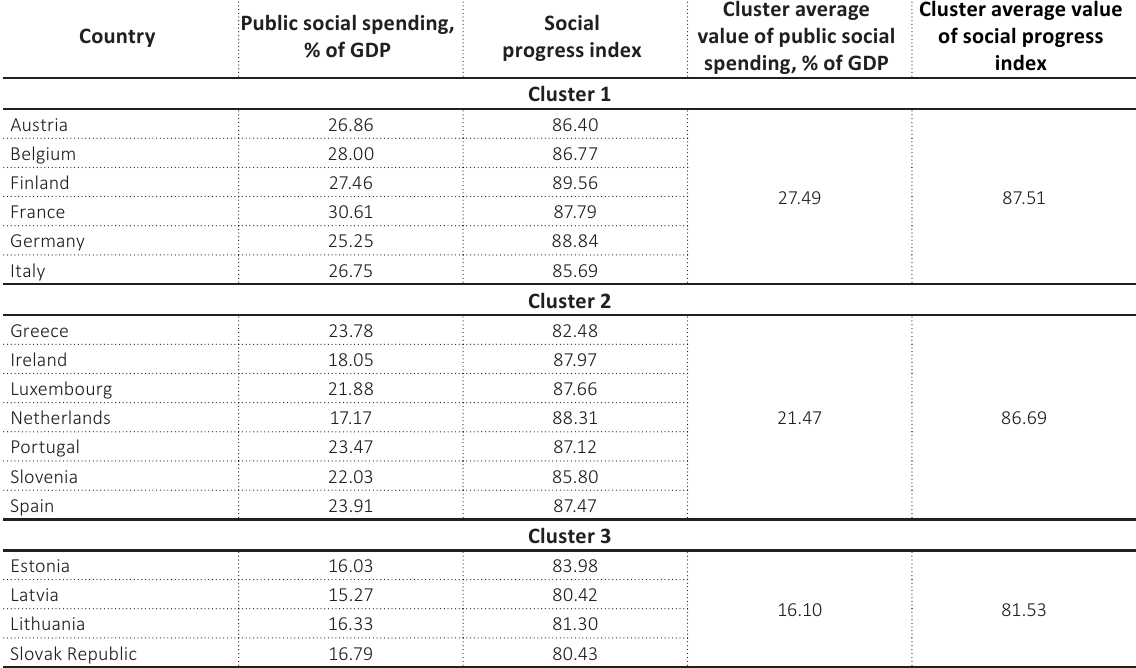
Table 5. Cluster composition based on social spending scope indicators and the social progress index and their average values